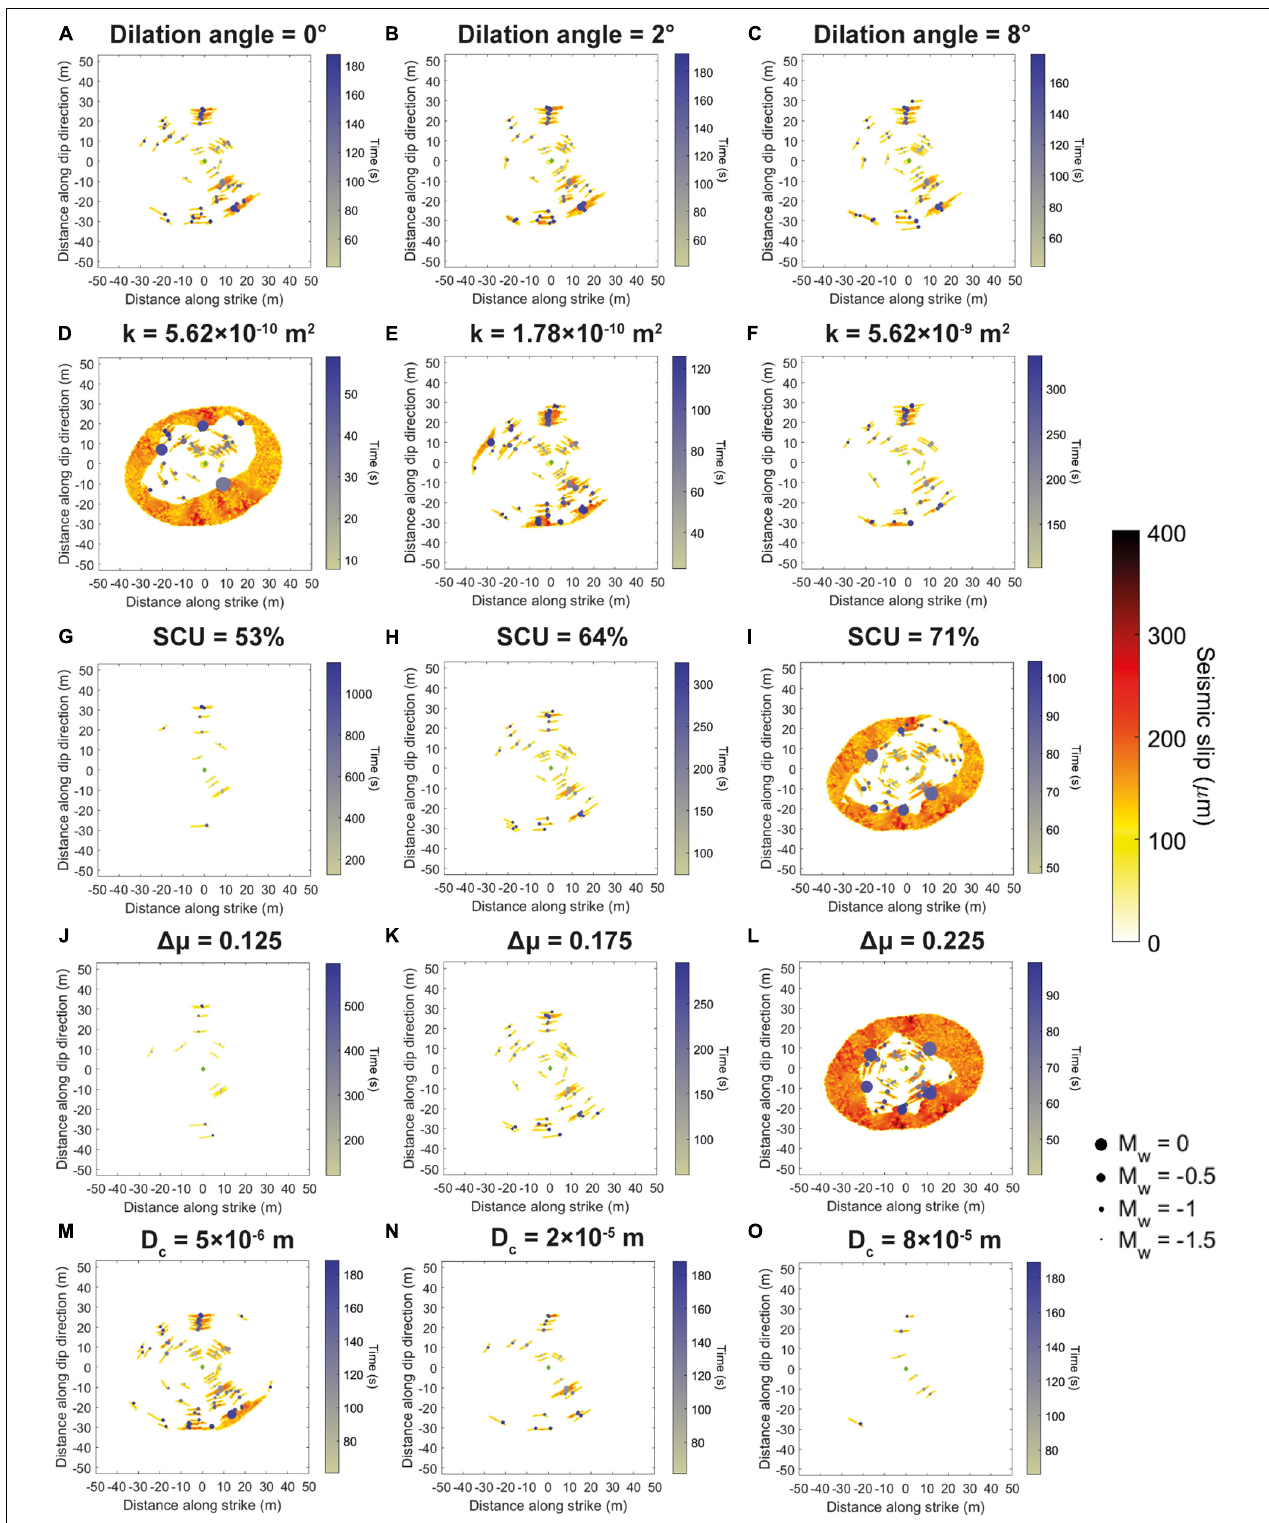
FIGURE 4 | Seismic slip on the fault at the end of the simulations for various dilation angles ( A: 0 ◦ ; B: 2 ◦ ; C: 8 ◦ ), permeabilities ( D: 5.6 × 10 − 10 m 2 ; E: 1.8 × 10 − 9 m 2 ; F: 5.6 × 10 − 9 m 2 ), stress criticalities ( G: 53%; H: 64%; I: 71%), friction drops ( J: 0.125; K: 0.175; L: 0.225), and critical slip distances ( M: 5 × 10 − 6 m; N: 2 × 10 − 5 m; O: 8 × 10 − 5 m). The seismic events generated during the test are represented by black disks whose size is function of their magnitude.